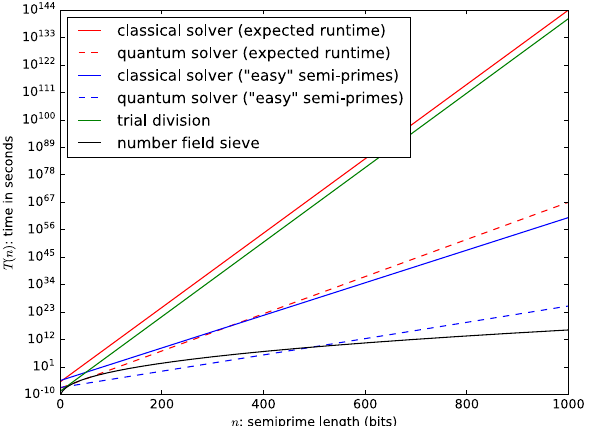
Figure 6. Comparison of efficiency of various factoring methods. The classical results are extrapolated from experimental data. The quantum results apply a quadratic speedup over the full classical computation. The number field sieve result plots L N [ 1 / 3, ( 64 / 9 ) 1 / 3 ] operations assuming the same number of operations per